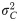
Predictions of BCV about the difference in probability between choosing option A and option B when a third option K is available (P[A|A,B,K] − P[B|A,B,K]).Here options are characterized by two attributes (price p and quality q). For car A, we assign Rp,A = 1 to price (low scores indicate high price) and Rq,A = 10 to quality. For car B, we assign Rp,B = 10 to price and Rq,B = 1 to quality. The graph considers the choice probability difference between option A and option B as a function of the reward amounts Rq,K (for quality; x axis) and Rp,K (for price; y axis) of a third option K (100000 trials are simulated for each condition; σC2 = 1 for simulations). Different parameter sets are shown. A: Simulation using μC = −2 and σR2=0.1. B: Simulation using μC = 2 and σR2=0.1. C: Simulation using μC = 0 and σR2=1. D: Simulation using μC = 0 and σR2=10.